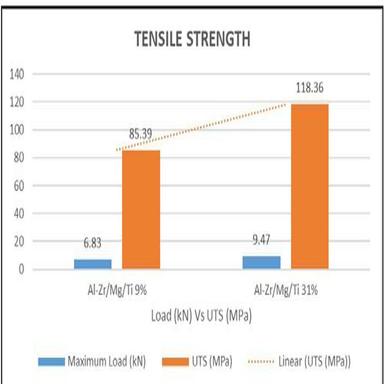
Load Vs Tensile Strength of Al NMMC with 9% and 31%